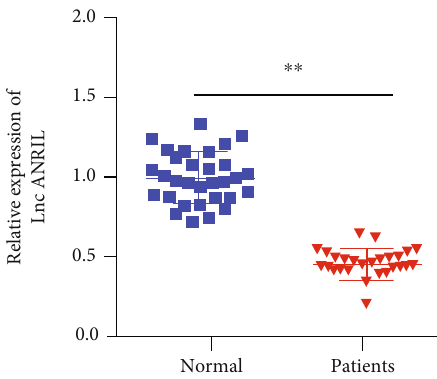
Figure 1: The expression of ANRIL was decreased in PDL tissues of periodontitis patients. PDL tissues from 30 patients with periodontitis and 30 healthy people were collected, and then, ANRIL level was detected by qPCR. ∗∗ P < 0 : 01